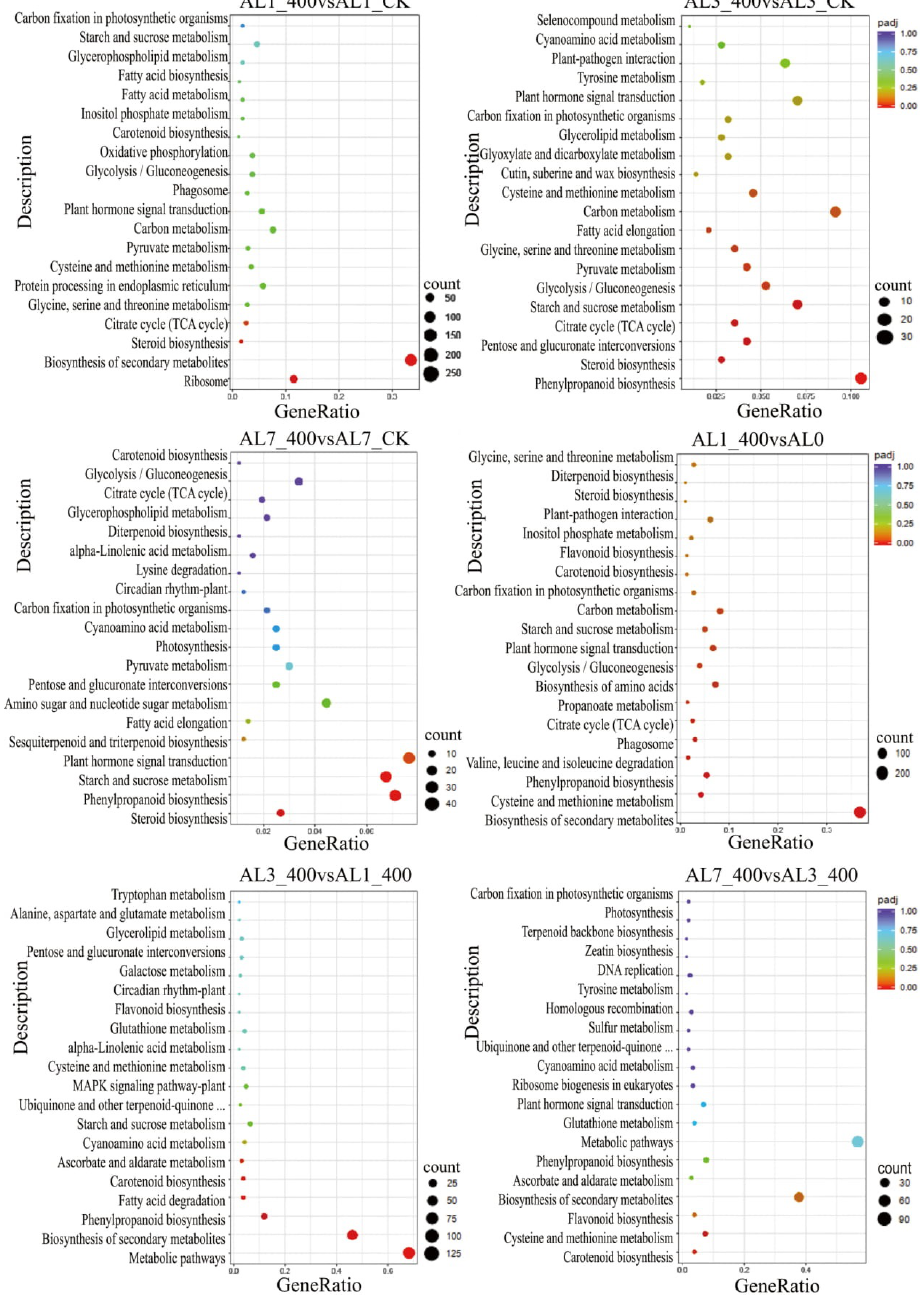
Figure 7. KEGG (Kyoto Encyclopedia of Genes and Genomes) enrichment of six comparative combinations of aluminum stress in different periods. The ordinate indicates the name of the pathway, the abscissa indicates the rich factor, the size of the dot indicates the number of differentially expressed genes in the pathway, and the color of the dot corresponds to different q value ranges. On the other hand, we also compared the three combinations of AL1_400 vs. AL0, AL3_400 vs. AL1_400, and AL7_400 vs. AL3_400 longitudinally to analyze the gene function clustering of N. cadamba after aluminum stress. We found that the key GO terms (Figure. 8) enriched in the biological